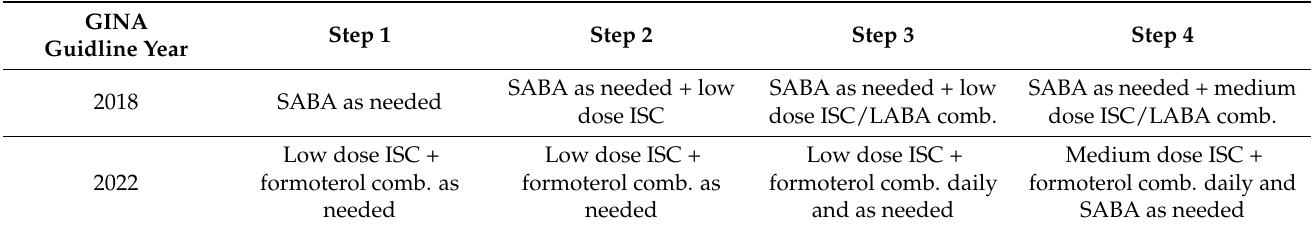
Table A1. A summary of the GINA Guidelines from 2018 compared with the GINA guidelines from